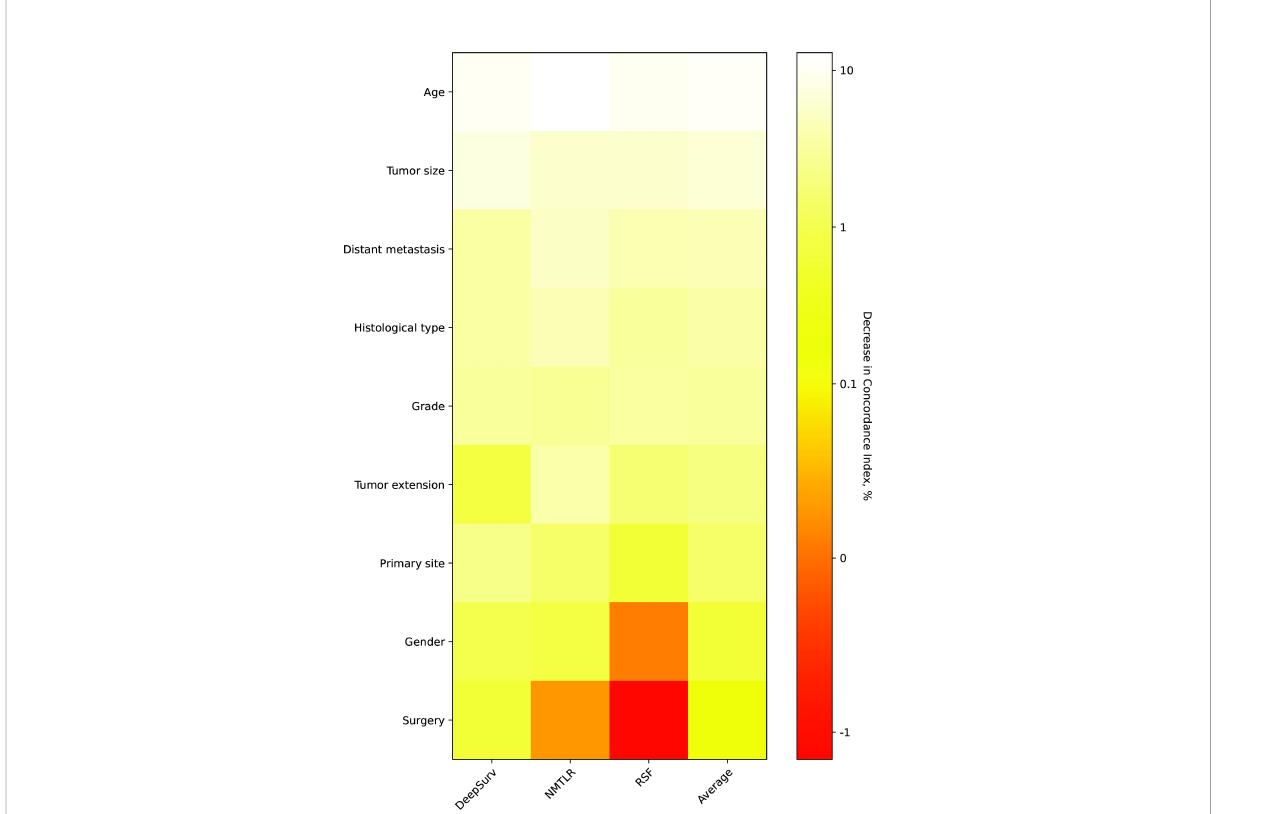
FIGURE 6 Heatmap of feature importance for DeepSurv, neural network multitask logistic regression (N-MLTR) and random survival forest (RSF) models. The values are expressed as a percentage reduction in the C-index after the value of a feature has been replaced by random numbers. Higher values suggest that a feature is more important in in fl uencing the predictive accuracy of the corresponding deep learning model.